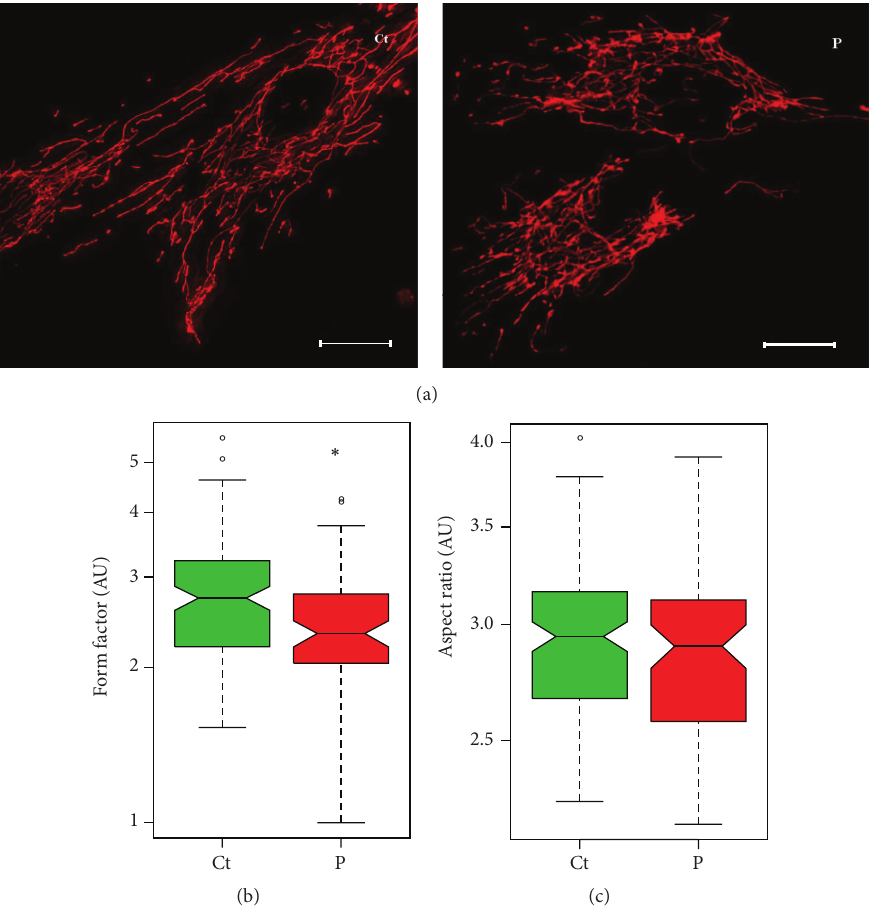
Figure 3: Mitochondrial network analysis of patient-derived and control fibroblasts. Mitotracker Red and live-cell microscopy were used to visualize the mitochondrial network. (a) Representative images of control fibroblasts (left) and patient fibroblasts (right). Scale bars = 20 𝜇 m. All images were assessed in regard to the degree of mitochondrial branching (form factor) and degree of mitochondrial elongation (aspect ratio).Thedistributionoftheseparametersingroupedpatient-derived(P)andgroupedcontrol(Ct)fibroblastsarerepresentedonlogarithmic scale in boxplots, 𝑁 = 40 . (b) Comparison of form factor, which was significantly lower in patient cells than in control cells ( 𝑝 = 0.0304 ). (c) Comparison of aspect ratio, which was similar in patient and control cells ( 𝑝 = 0.1638 ). ∗ 𝑝 < 0.05 ; ∘ , outlier; AU, arbitrary units; 𝑁 ; cells